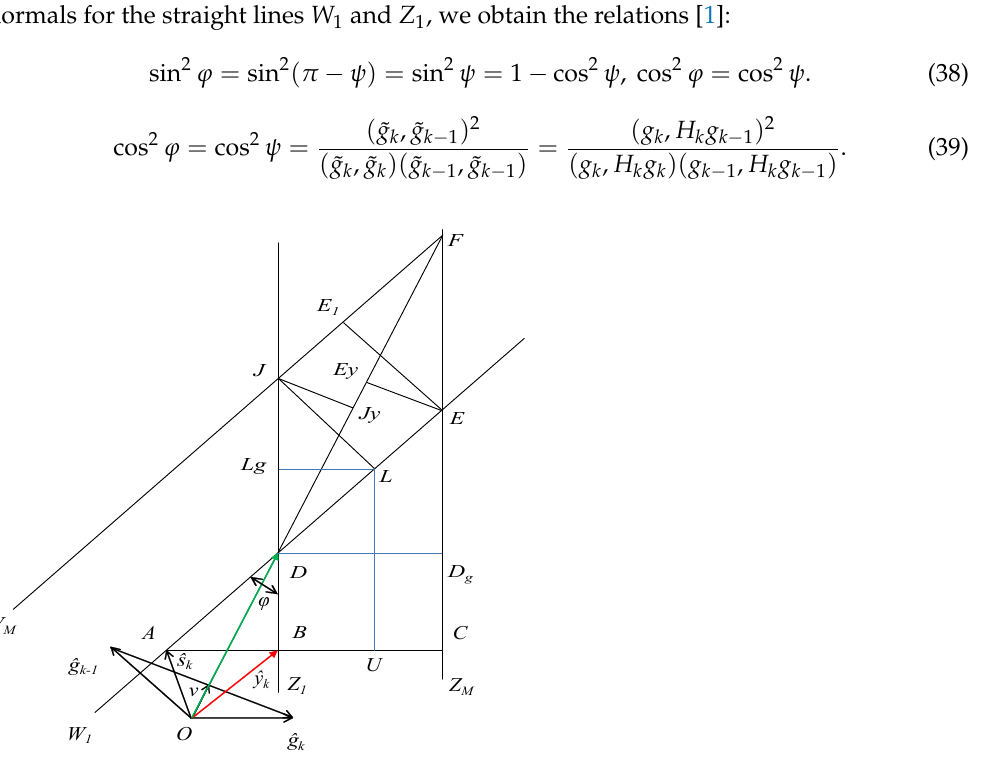
Figure 5. Characteristics of the set G in the plane of vectors ˜ g k , ˜ g k − 1